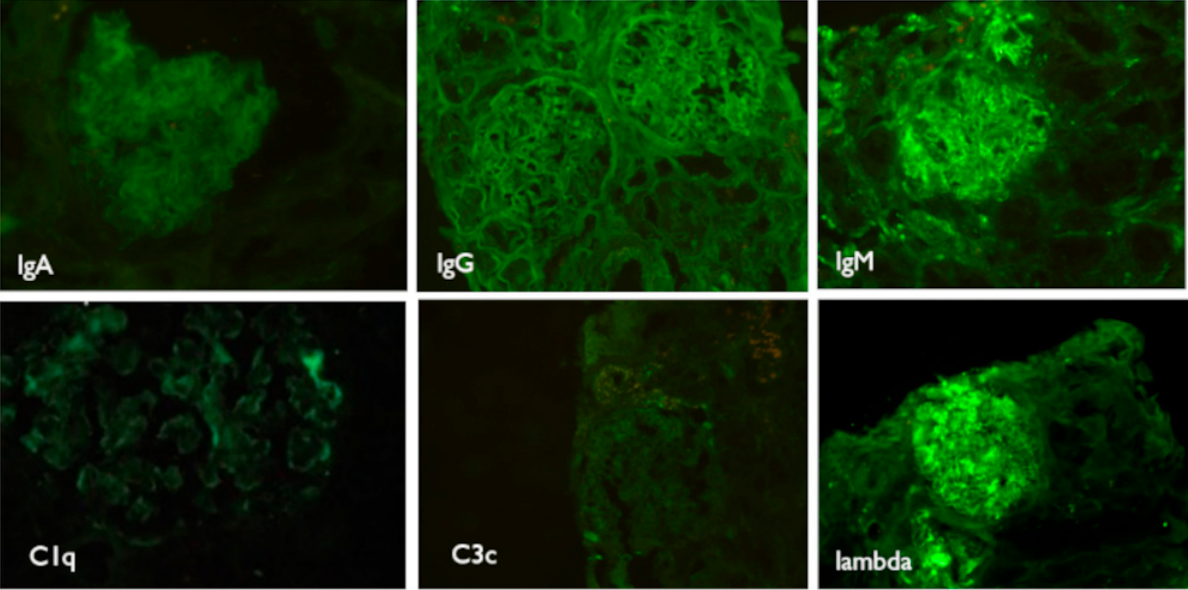
Figure 5. Immunofluorescence. Weak IgA positivity in GBM and mesangial areas. Negative IgG. Weak positivity fine granular IgM. Negative C1q and C3. Moderate positivity for lambda chains with granular aspect. IgA—immunoglobulin A; GBM—glomerular basement membrane; IgG—immunoglobulin G; IgM—immunoglobulin M.